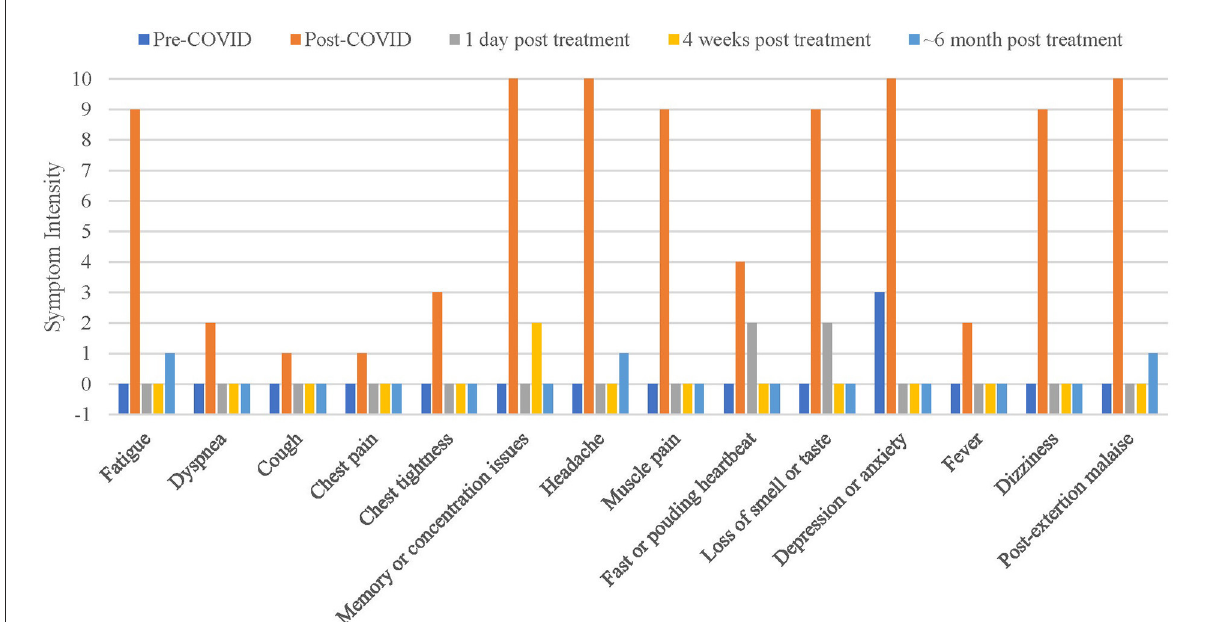
FIGURE1 Intensity of Long COVID symptoms over time. Data was collected retrospectively for pre-COVID. Y-axis was set to − 1 to visualize a score of zero [visualization was chosen following Liu and Duricka